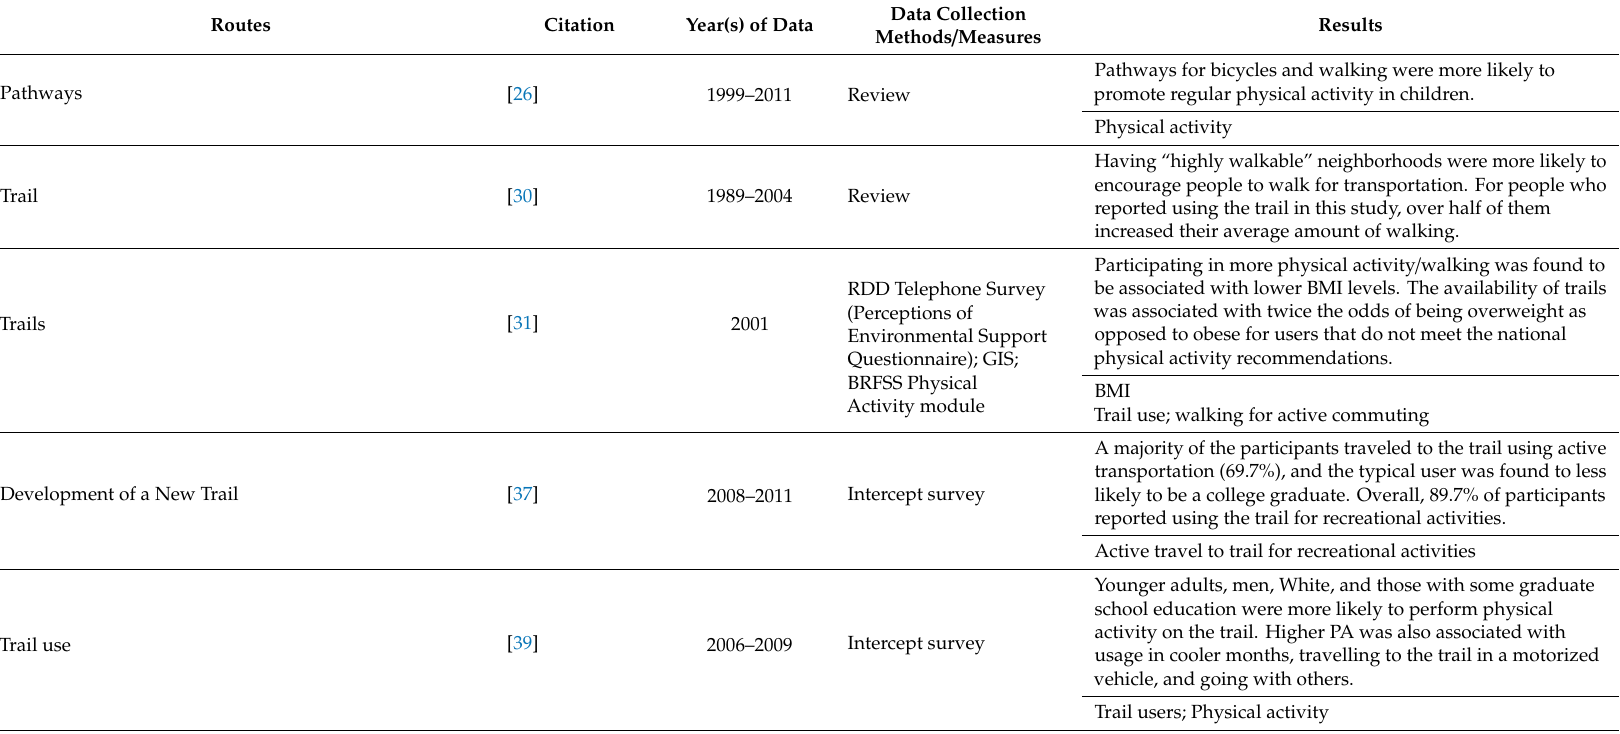
Table A1. Correlates of Physical Activity and Features of Transportation Systems (Routes) and / or Built Environment and Land-Use Destinations or Both Routes and Destinations that May Support Planning and Implementation of Programs to Increase Trail Use among Youth from Under-Resourced